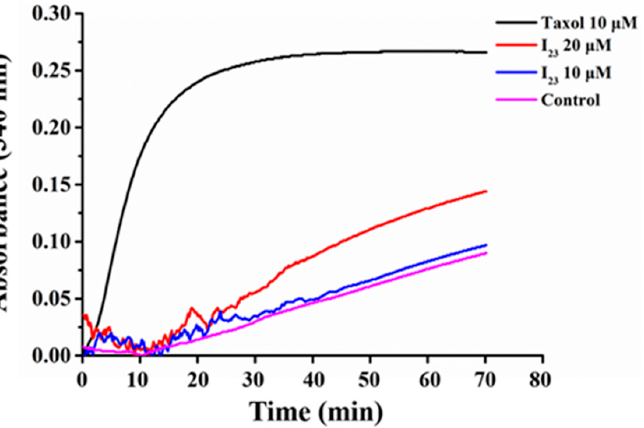
Figure 4. Progress of tubulin polymerization in the presence of 10 µ M and 20 µ M compound I 23 . Taxol (10 μ M) was used as positive polymerization control, whereas untreated tubulin was used as negative control.